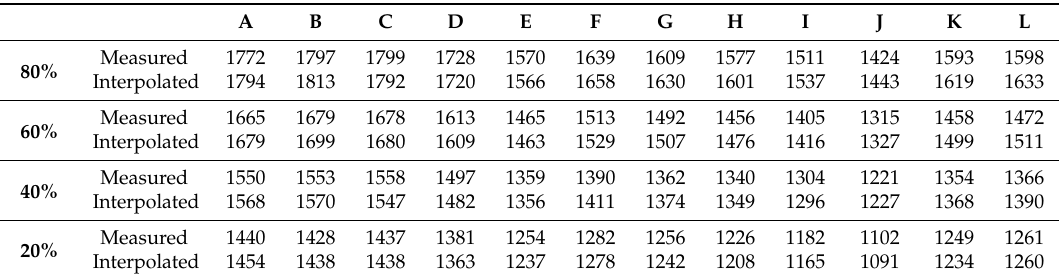
Figure 5. Measured and interpolated intensity values for the four reference targets at scanning geometries from A to L.